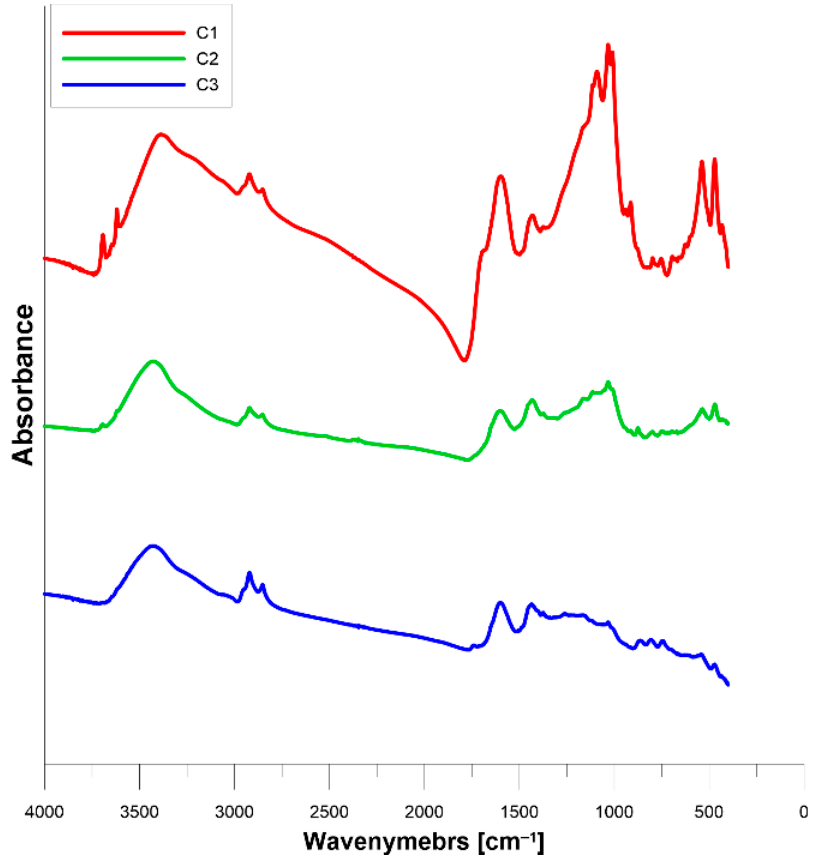
Figure 1. FTIR spectra of coals C1, C2 and C3. Scanning electron microscopy–energy dispersive X-ray spectroscopy (SEM/EDS) anal- ysis was carried out with the aid of JEOL JSM-7500F, coupled with an AZtecLiveLite Xplore 30 (Oxford Instruments) system. The secondary electron detector provided SEI images, and the back-scattered electron detector provided BSE (COMPO) micrographs. SEM images were recorded for the samples coated with 30 nm Cr. SEM (Scanning Electron Microscopy) makes use of secondary electron signal imaging to observe the surface morphology of the sample, to infer material components and to reveal the microstructure on the micro-